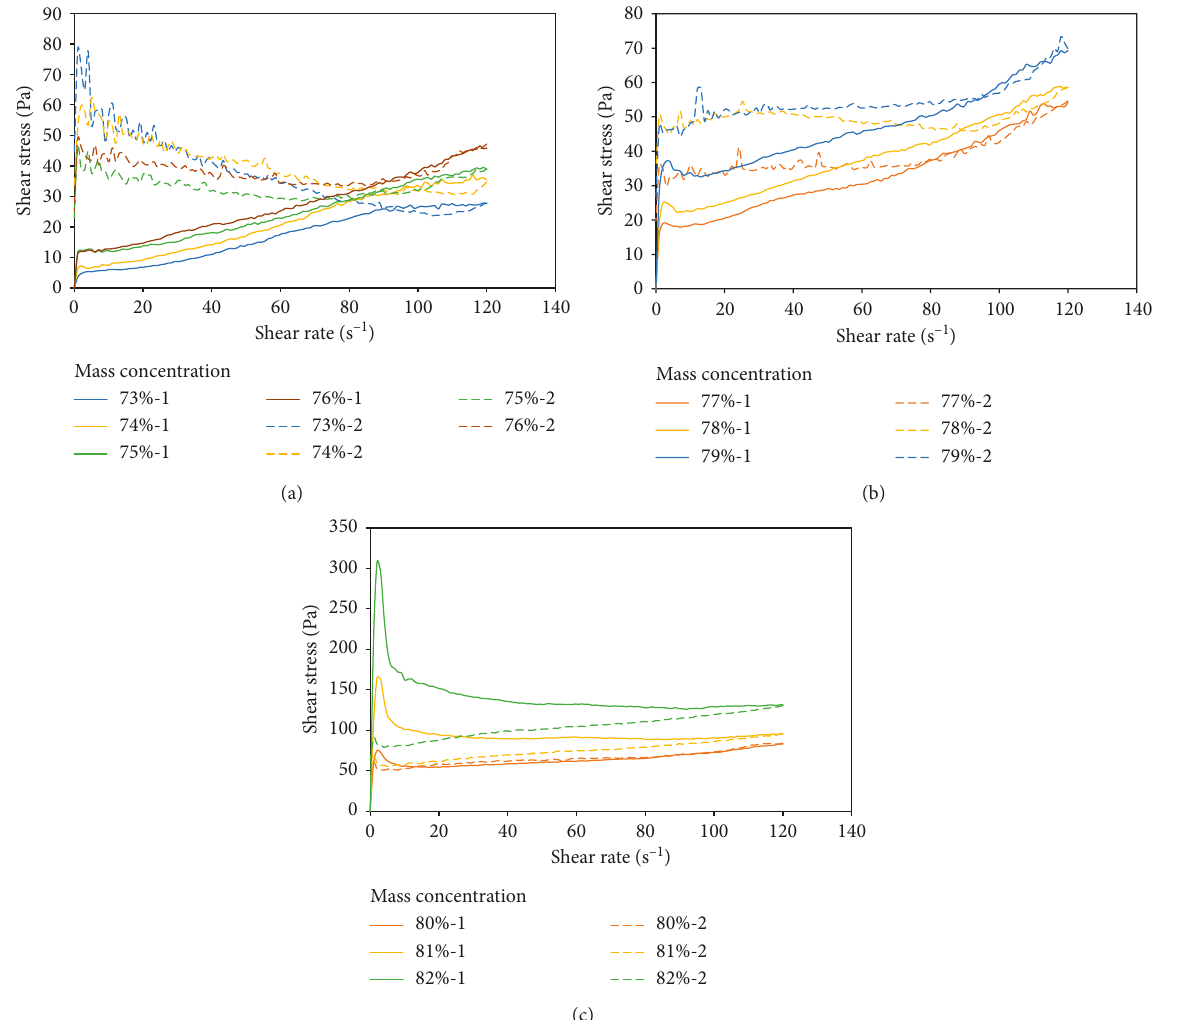
1 ; %-2 dashed lines represent −